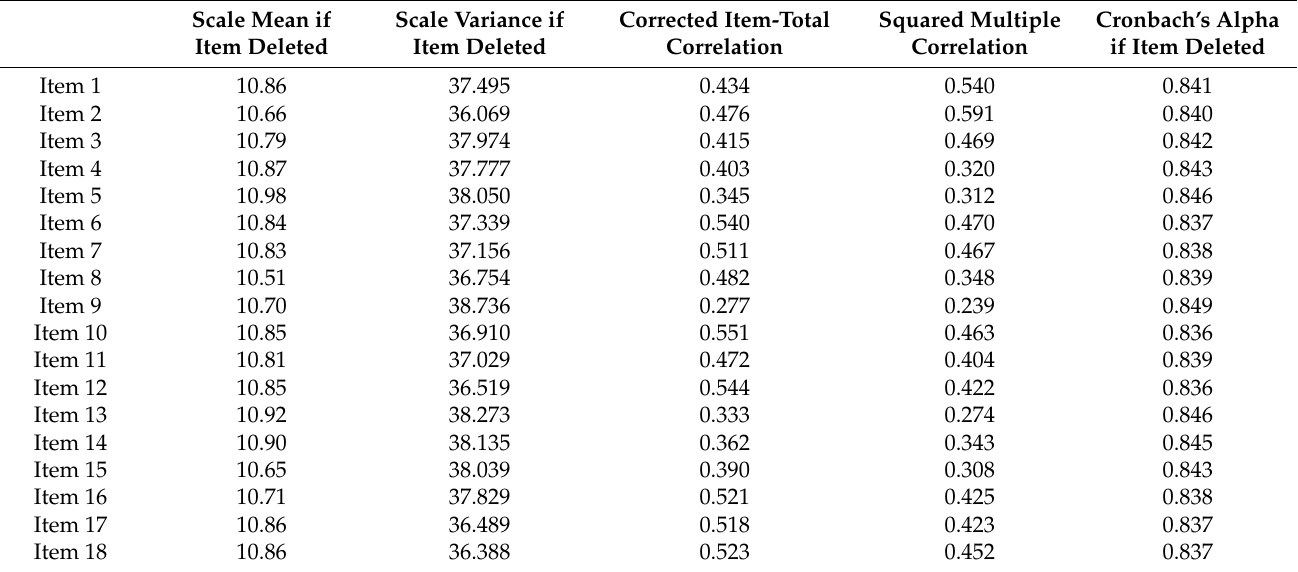
Table 1. Reliability analysis of the